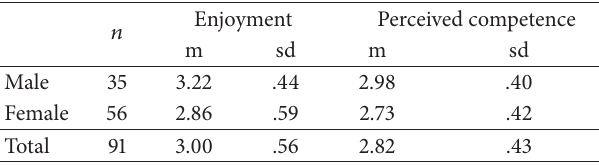
Table 2: Descriptive statistics of teacher attitudes towards science and technology (range